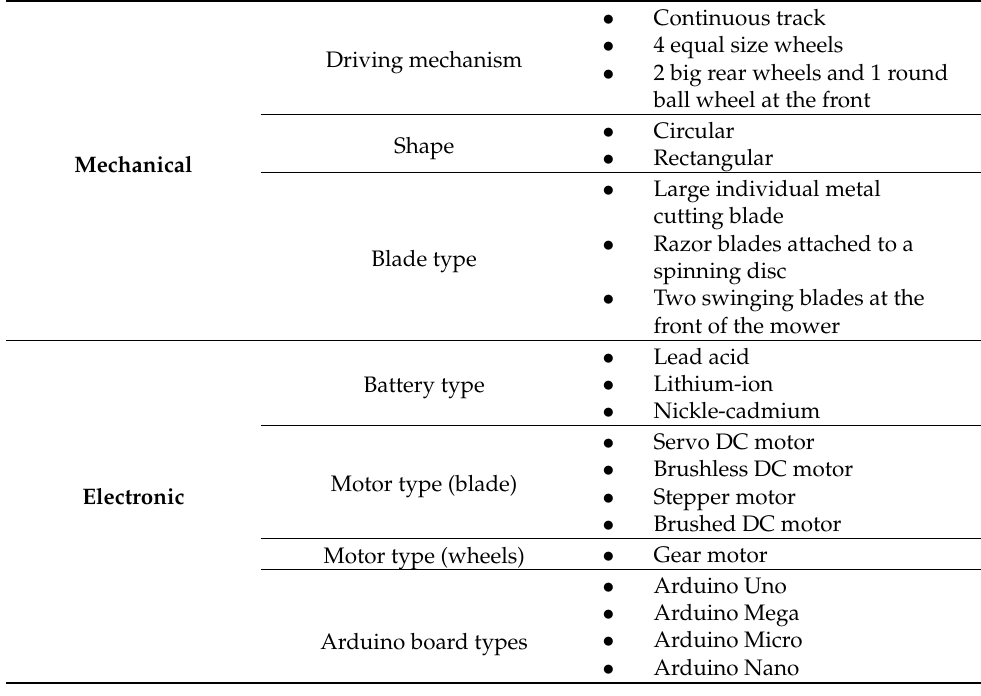
Table 2. List of all common choices for each component.